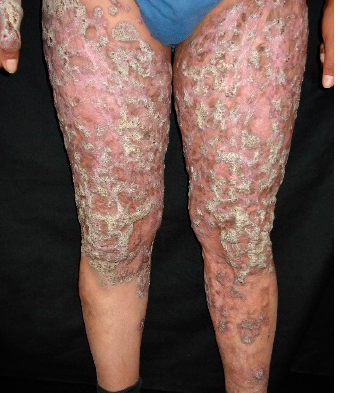
Figure 1. Extensive cutaneous disseminated sporotrichosis associated to chronic alcoholism.